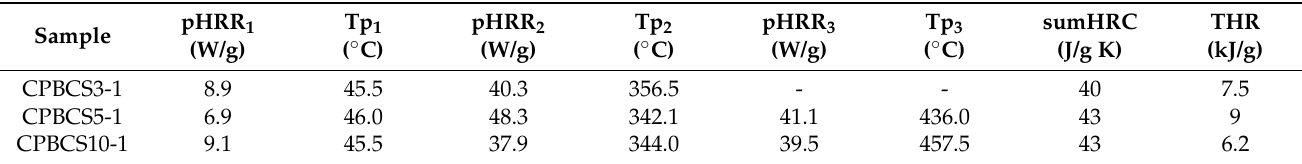
Table 3. Data obtained from PCFC tests.